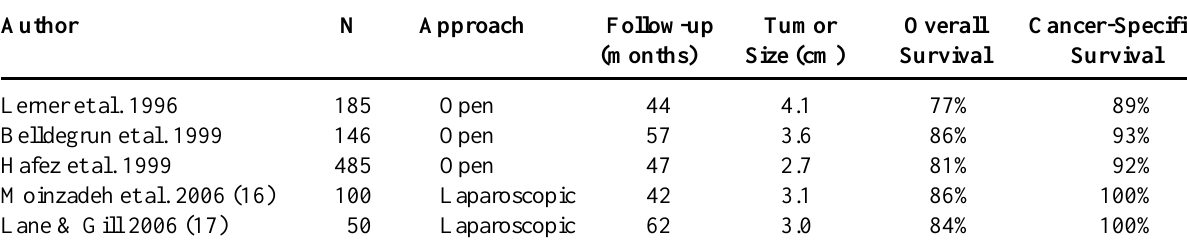
Table 2 – Partial nephrectomy series oncological outcomes.